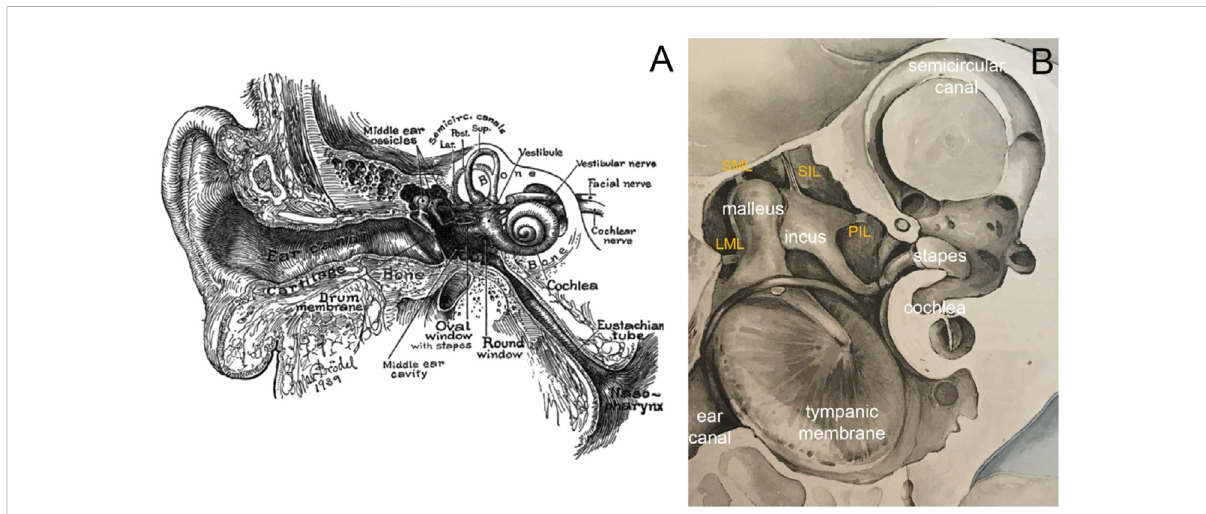
FIGURE 1 (A) Image of the ear in cross-section by Max Brödel. The outer ear consists of the pinna and the ear canal, the middle ear of the tympanic membrane, the middle ear cavity, ossicles, and various ligaments and muscles. The three middle ear ossicles transmit the acoustic energy to the cochlea, responsible for hearing. Nerve fi bers connect the inner ear via the eighth cranial nerve to the brainstem. The eustachian tube ventilates the middle ear. (B) Modi fi ed image by Bertolini and Leutert (1982), showing a magni fi ed view of the middle ear. Essential to holding the chain of ossicles in place are the ligaments. The image shows the lateral mallear ligament (LML), superior mallear ligament (SML), superior incudal ligament (SIL), and the posterior incudal ligament